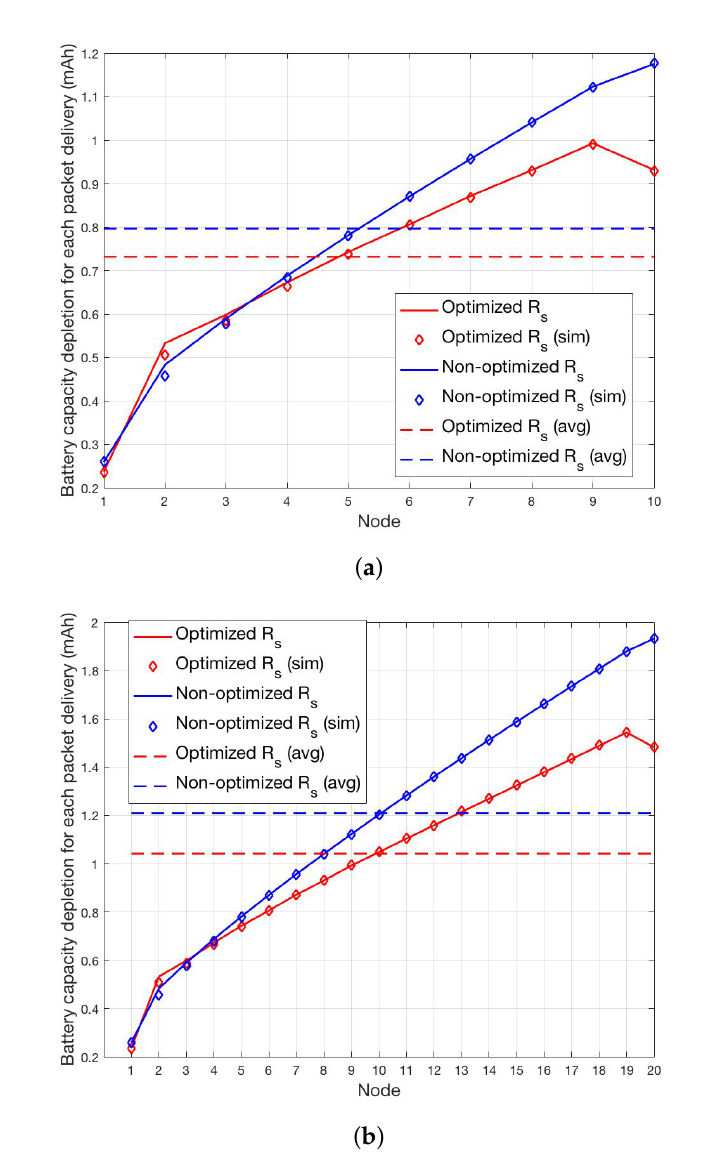
Figure 11. Per-node and average total battery capacity depletion for the optimized and non-optimized schemes for N = 10 ( a ) and N = 20 ( b